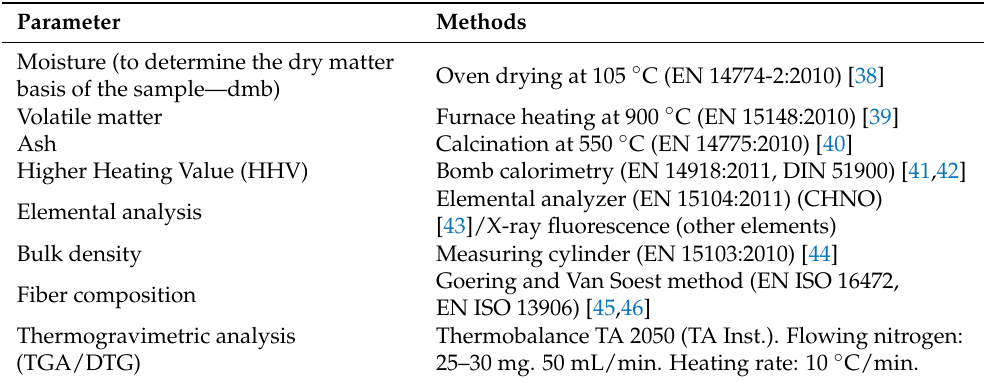
Table 2. Analytical methods used for the characterization of the prickly-pear biomass. Parameter